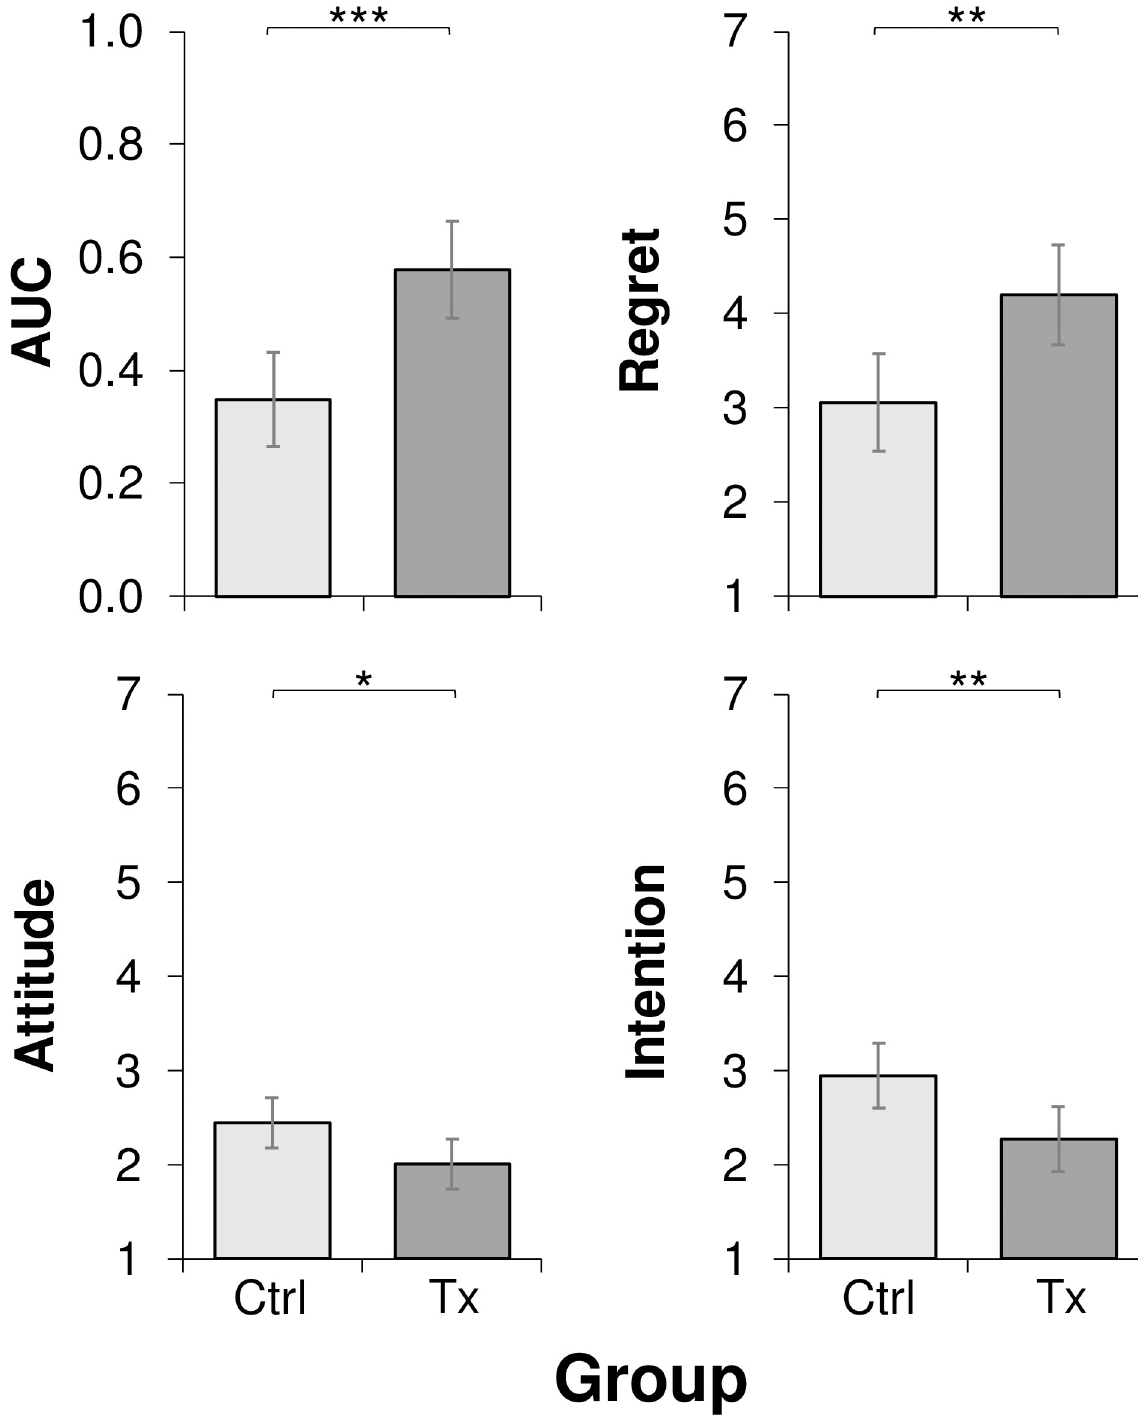
Fig 2. Adjusted means for area under the curve (AUC), anticipated regret due to texting while driving (regret), attitudes toward texting while driving (attitude), and intention of texting while driving in the future (intention) for the treatment (Tx) and control (Ctrl) groups. Error bars represent 95% confidence intervals. � p < .05. �� p < .01. ��� p < .001.